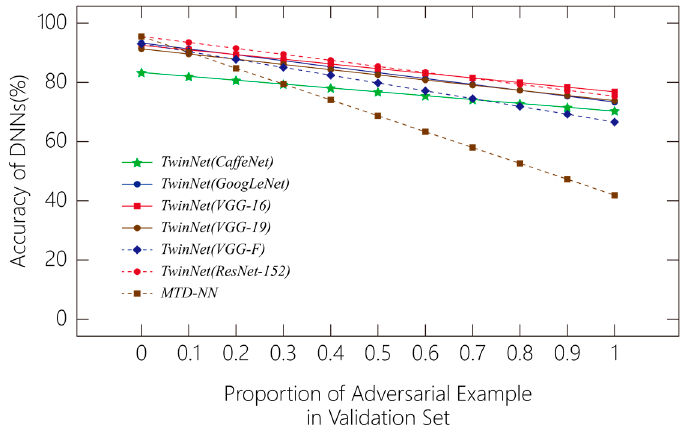
Figure 7. Accuracy of the deep neural network (DNN) when the proportion of adversarial example in the validation set varies.